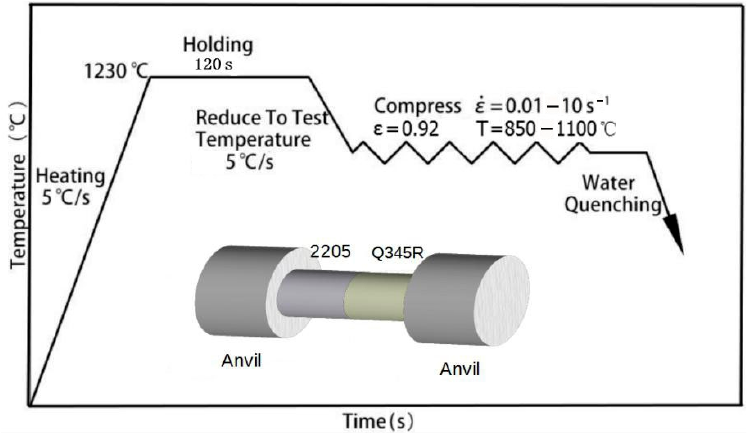
Figure 2. Flow chart of thermal compression composite.